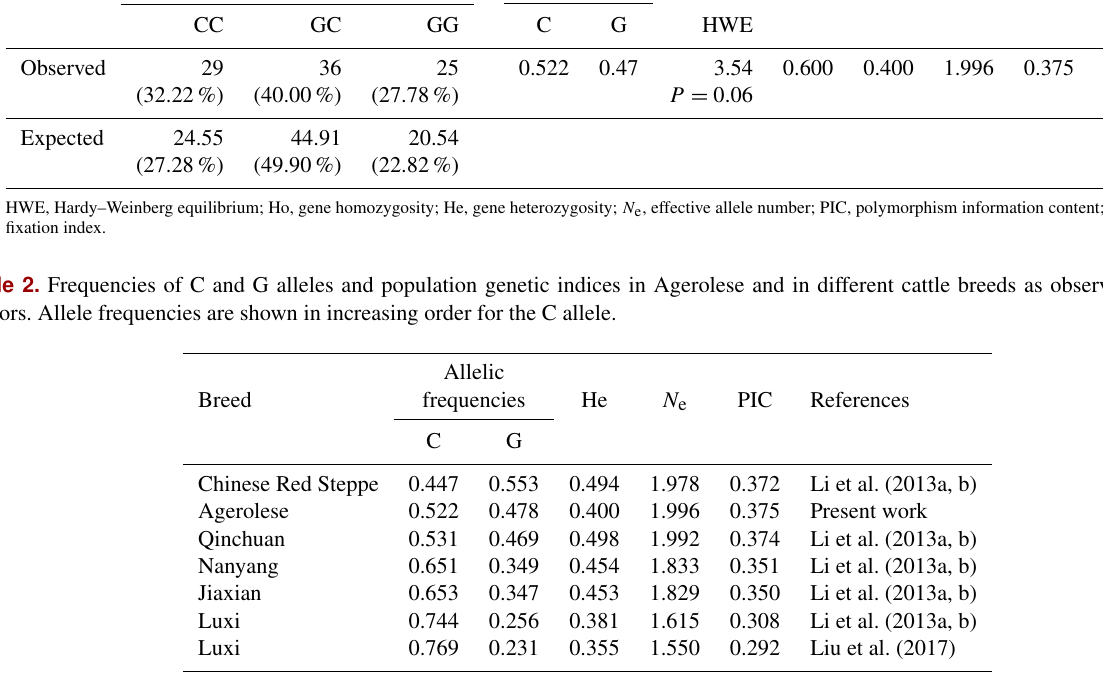
Table 1. Observed and expected numbers and percentages (in brackets) of genotypes at the g.-274C < G locus, allele frequencies and population genetic indices in the sample of Agerolese cows. Allele Genotype frequencies frequencies X 2 Ho He N e PIC F IS GC GG C G HWE Observed